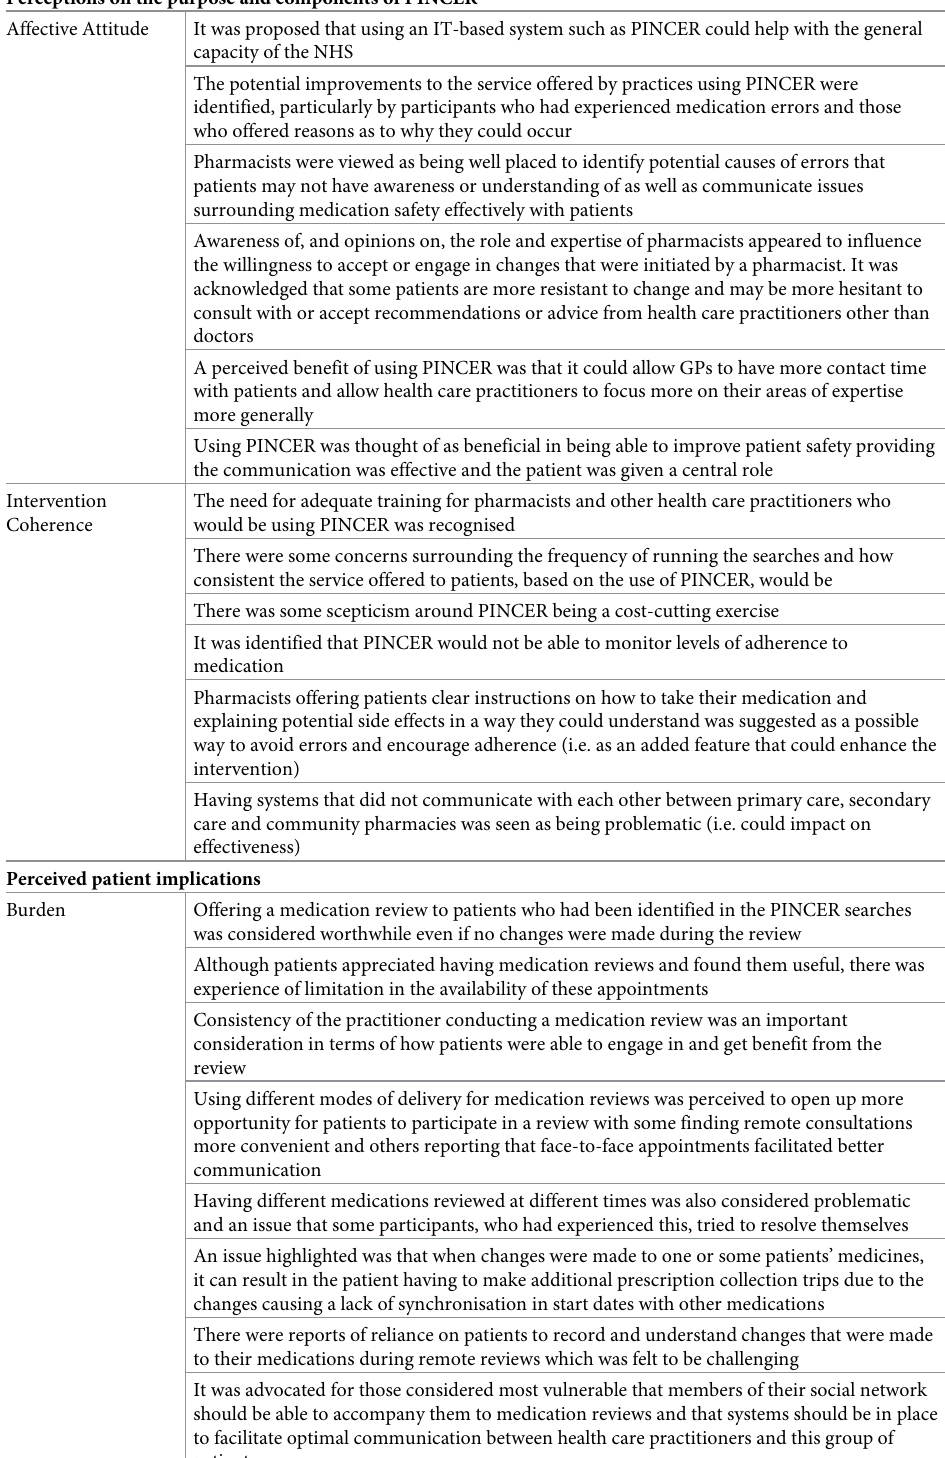
Table 3. Summary of results from mapping the themes to the constructs of the Theoretical Framework of Accept- ability